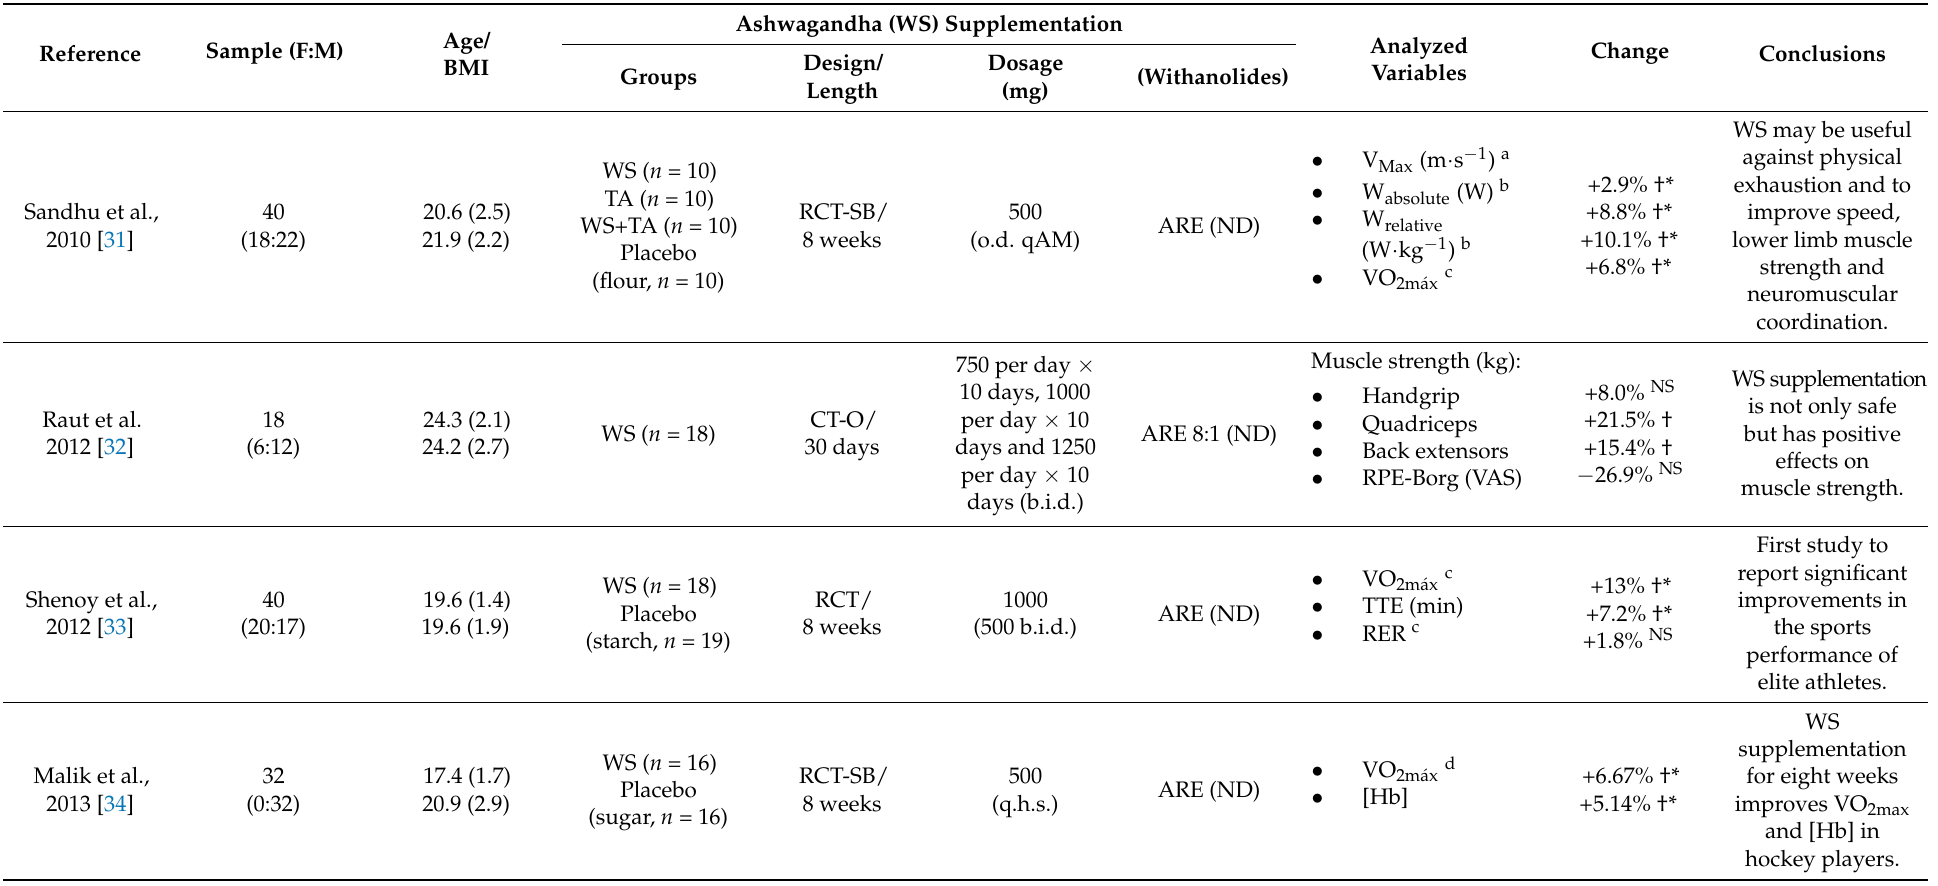
Table 1. Evidence of the effects of Ashwagandha supplementation on physical